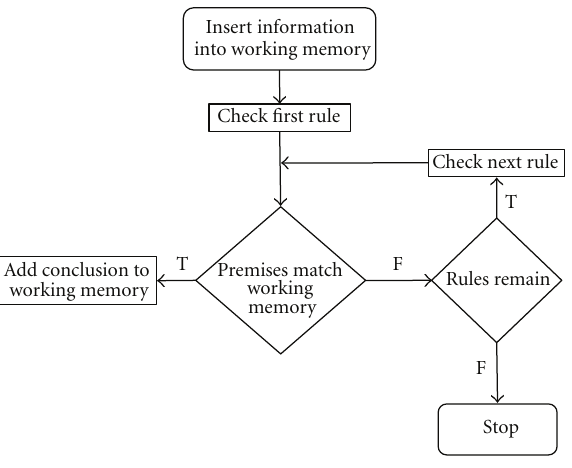
Figure 5: Forward chaining inference process [20].